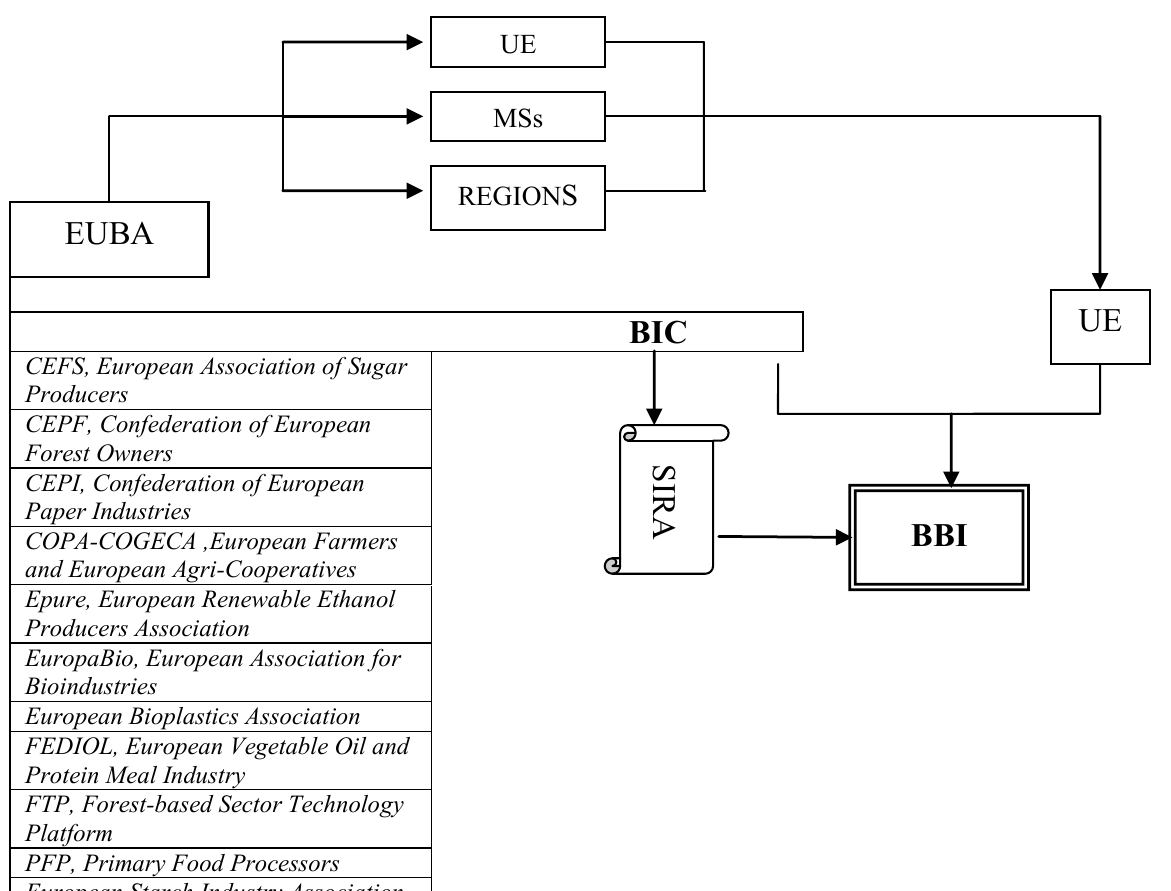
Fig. 2 – The official relationships between the biobased industries and the European Union. Source: own figure on data by http://biconsortium.eu; www.bbi-europe.eu; www.bioeconomyalliance.eu; BIC, 2013